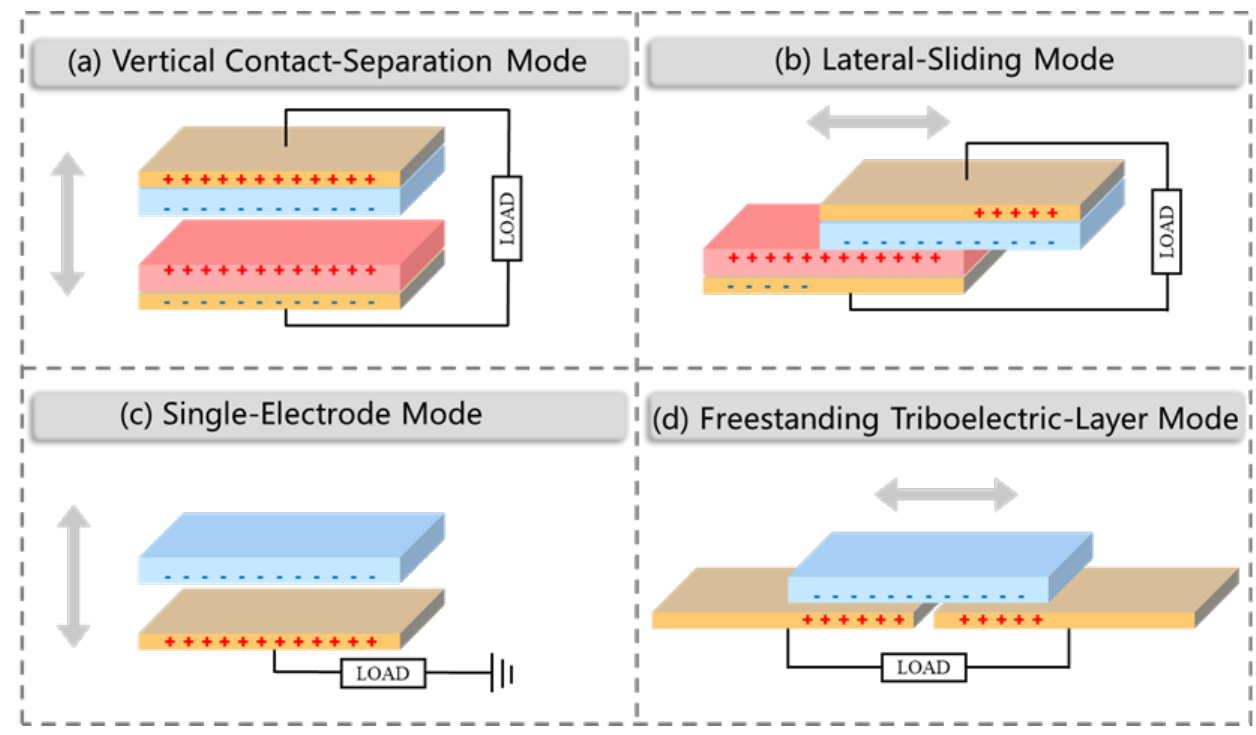
Figure 2. The basic principle of TENG: ( a ) Vertical contact-separation mode. ( b ) Lateral sliding mode. ( c ) Single-electrode mode. ( d ) Freestanding triboelectric-layer mode.